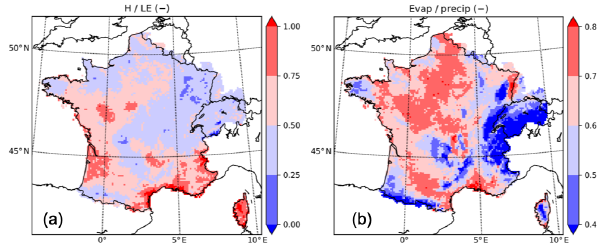
Figure 12. Maps of the mean annual Bowen ratio (a) and evapo- ration to precipitation ratio (b) for SIM_NEW on average over the period